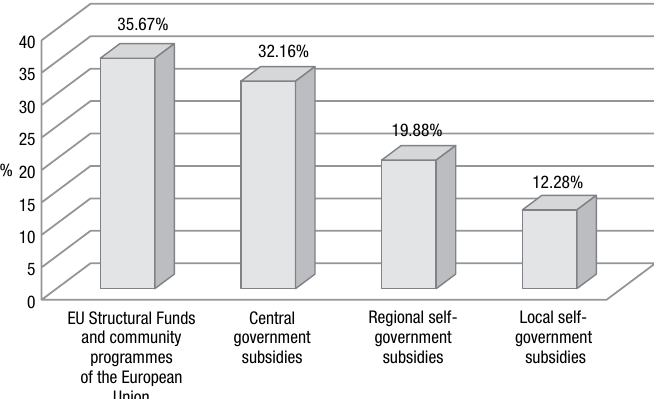
Fig. 1. Percentage of public funds shares in the cluster budgets in the countries of innovation leaders